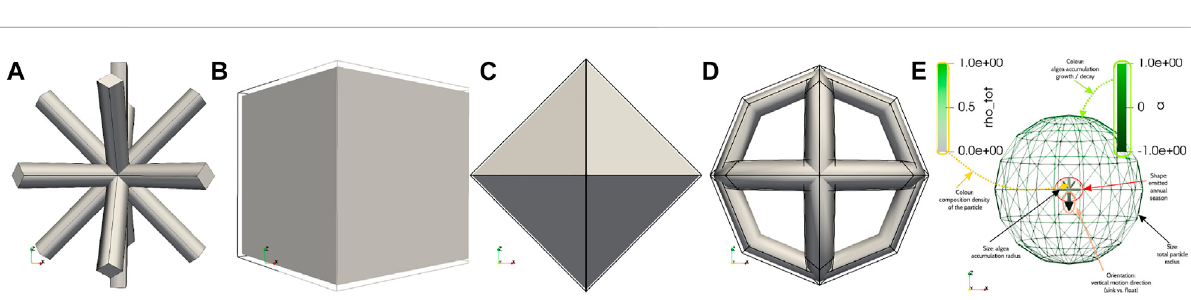
FIGURE 14 Depiction of the seasonal glyphs for December-January-February (A) , March-April-May (B) , June-July-August (C) and September-October- November (D) .Innorthernhemispheresemantics,theymaptowinter (A) ,spring (B) ,summer (C) andautumn (D) .ThemappingofLagrangianparticle attributes to the visual marks and visual channels of the complex glyph is illustrated in (E)